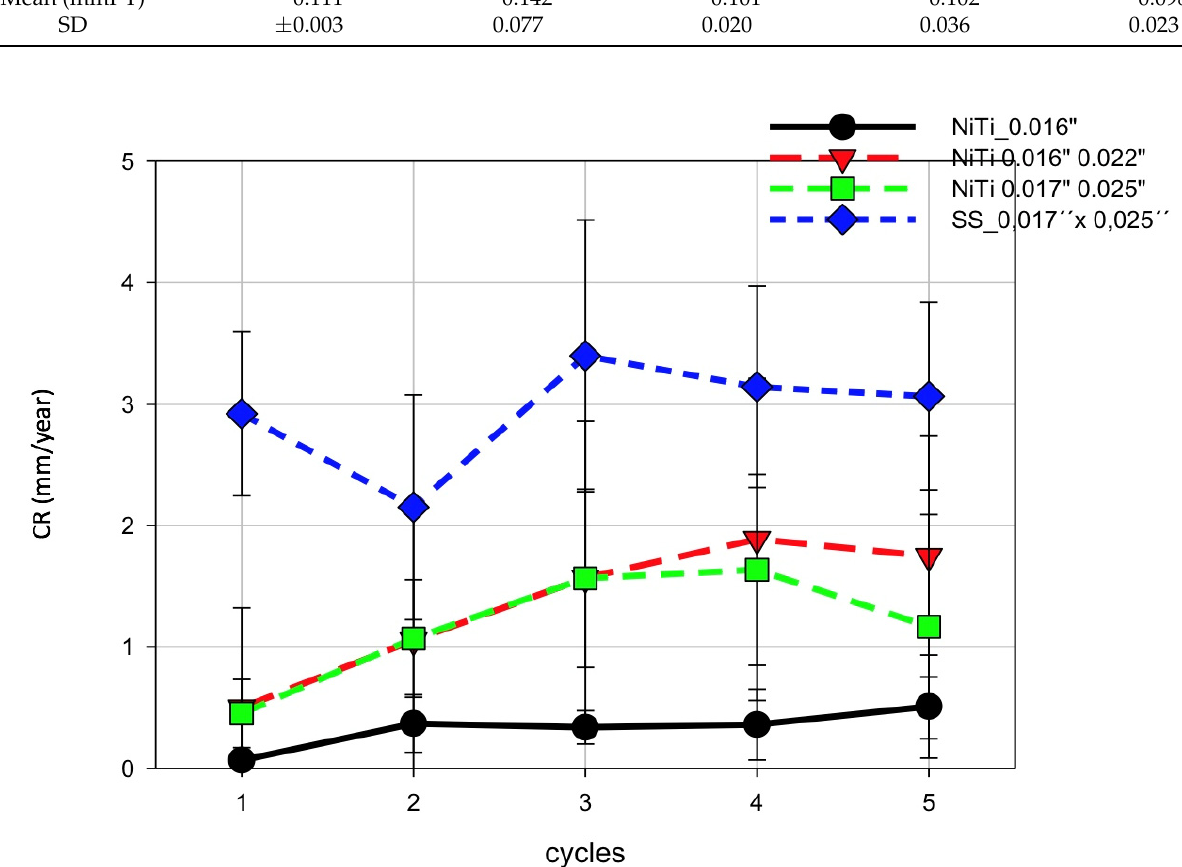
Figure 10. A comparison of CR of the investigated wires in Ringer’s solution at pH = 1 and RT. The CR on the SS wire surfaces was higher than on NiTi. Interestingly, there were differences between the various dimensions of the NiTi wires. In all cases, the CR increased along with the number of cycles and correlated with time since one cycle corresponded to a time interval of 340 s. The mean CR of SS was 3mm/year, that of NiTi 0.017” × 0.025” was 1.5 mm/year, and that of NiTi 0.016” was 0.5. mm/year. Thus, NiTi 0.017” × 0.025” seems to have a CR three times higher than that of the 0.016” NiTi wire. These results are also shown in Figure 11a,b, where the averaged CR and E corr for the respective wires are summarized.